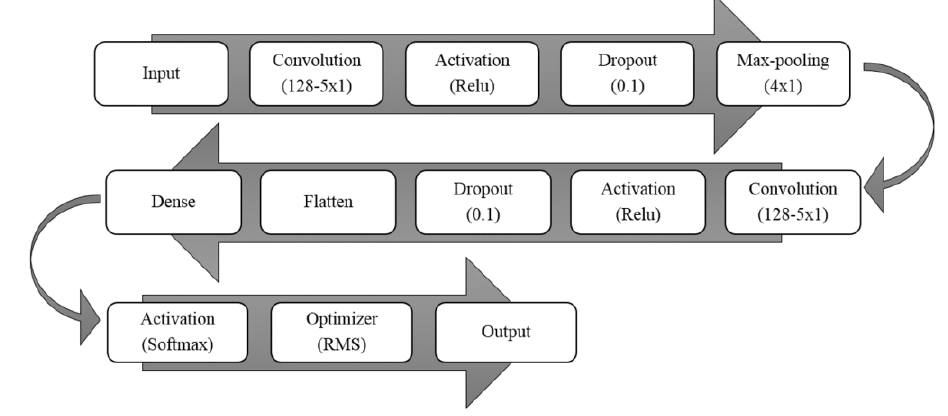
Figure 7. CNN Architecture for high-level feature extraction and